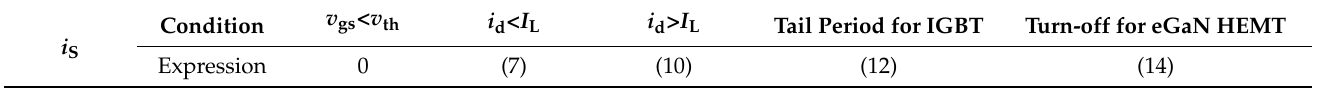
Table 1. Key expressions for i S in the proposed